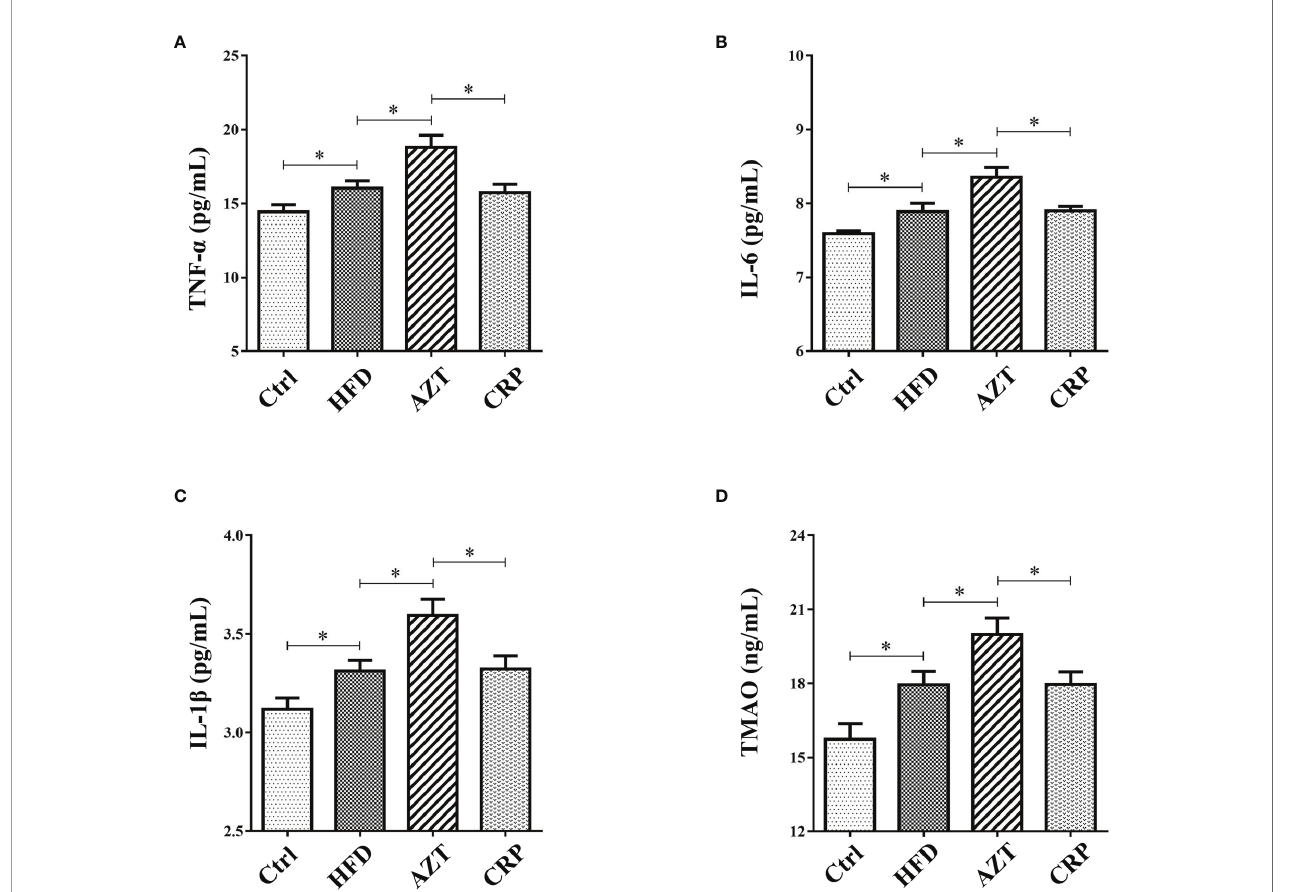
FIGURE 5 | Serum in fl ammation and trimethylamine N-oxide (TMAO) levels between the groups. (A) Tumour necrosis factor- a (TNF- a ). (B) Interleukin-6 (IL-6). (C) Interleukin-1 b (IL-1 b ). (D) TMAO. Differences were assessed by ANOVA. Data are expressed as the mean ± SEM, n = 10 in each group. *P <